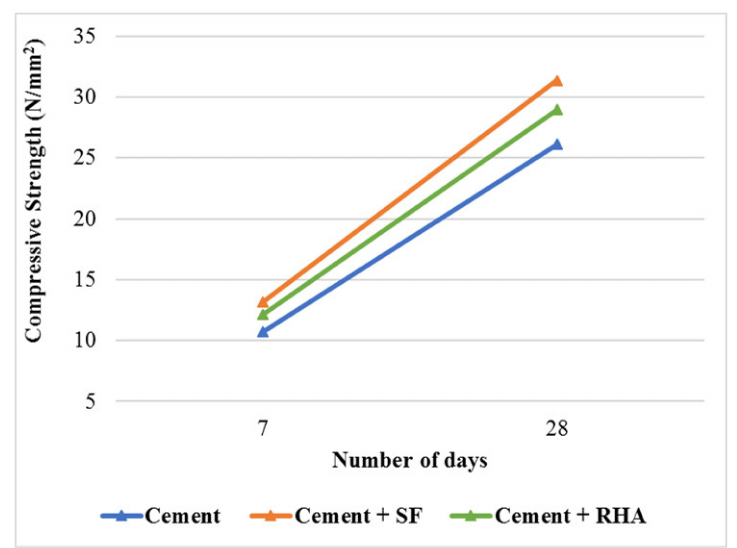
Figure 6. Pozzolanic strength activity test.